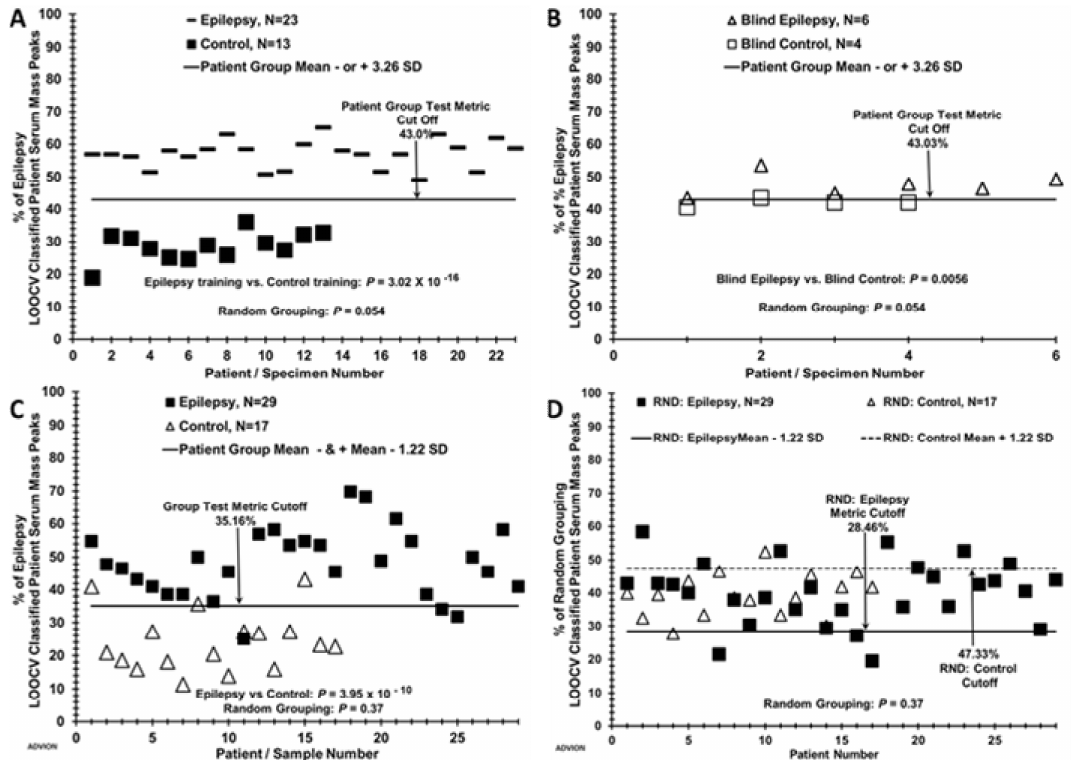
Figure 2. Distinguishing blinded “left out” sera samples, and LOOCV with a lower cost desk top mass spectrometer. ( A ) Six blinded epilepsy and 4 control samples from each group were removed from the database and the remaining samples (N = 23 for epilepsy and 13 for control) were used as a training set. A % LOOCV classified mass peak group test metric cut-off of 43.0% was established 3.26 SD’s from each respective group mean as described in the methods. ( B ) Six blinded epilepsy samples and 4 control samples were LOOCV tested against the test metric cut off of 43.0% determined by the training group dataset. ( C ) Epilepsy patient and control % scores for the LOOCV dataset (N = 29 epilepsy and 17 control) obtained using a small-footprint, lower ion-resolution, and limited m/z